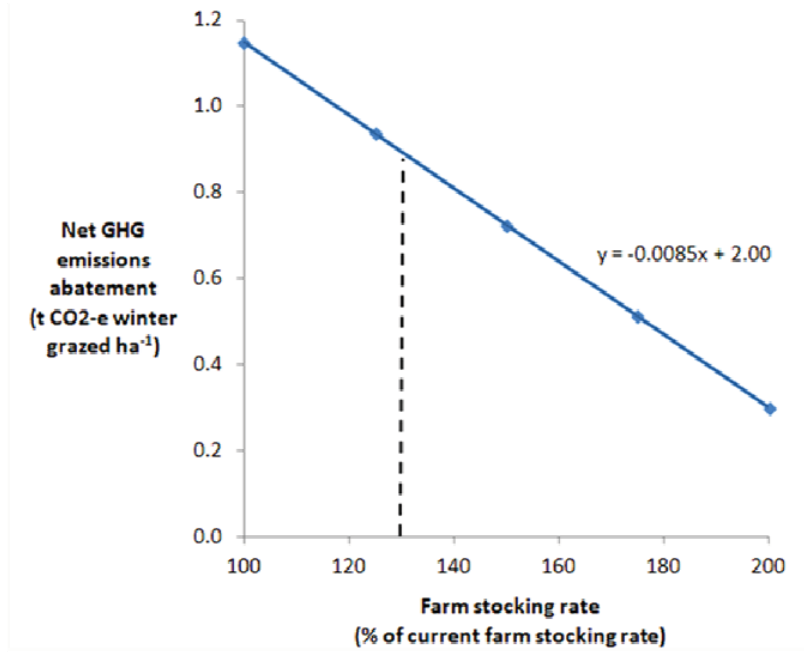
Figure 1. Relationship between farm stocking rate and the greenhouse gas (GHG) emissions abatement value of establishing Kikuyu pasture in place of annual pasture, based on a linear increase in farm GHG emissions with soil carbon storage kept constant. The vertical checked line indicates the likely change in farm stocking rate based on MIDAS bioeconomic modelling [10].